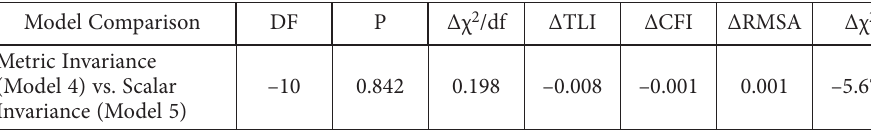
Table 9. Differences between countries: multiple comparisons test